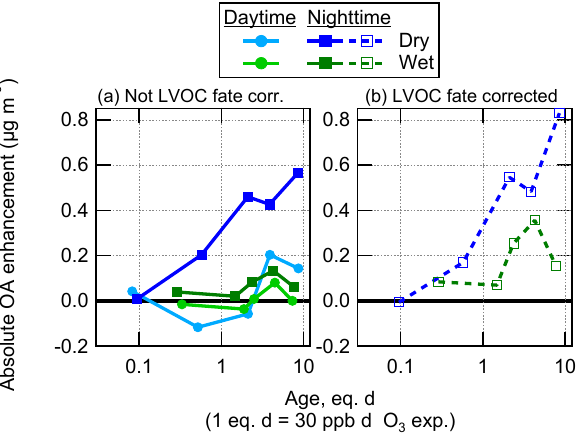
Figure 6. Absolute OA enhancement after O 3 oxidation in the OFR as a function of photochemical age, shown as binned averages for the wet and dry seasons at the T3 measurement site, and split into daytime (06:00–18:00LT) and nighttime (18:00–06:00LT) data. These data are shown both not corrected (a) and corrected (b) for LVOC